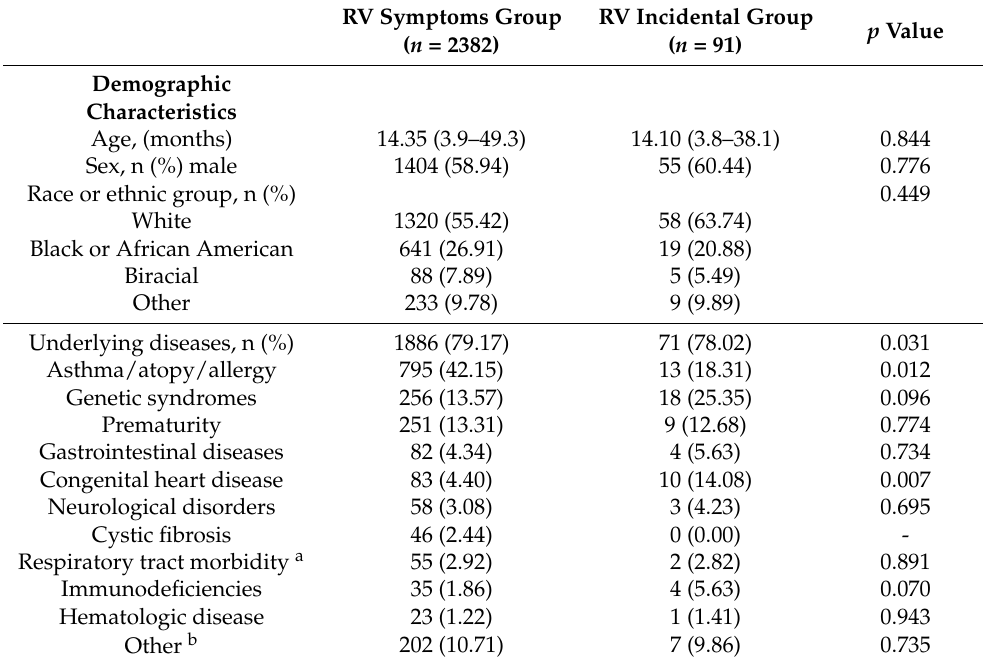
Table 3. Demographic characteristics and underlying diseases of children with compatible and non-compatible